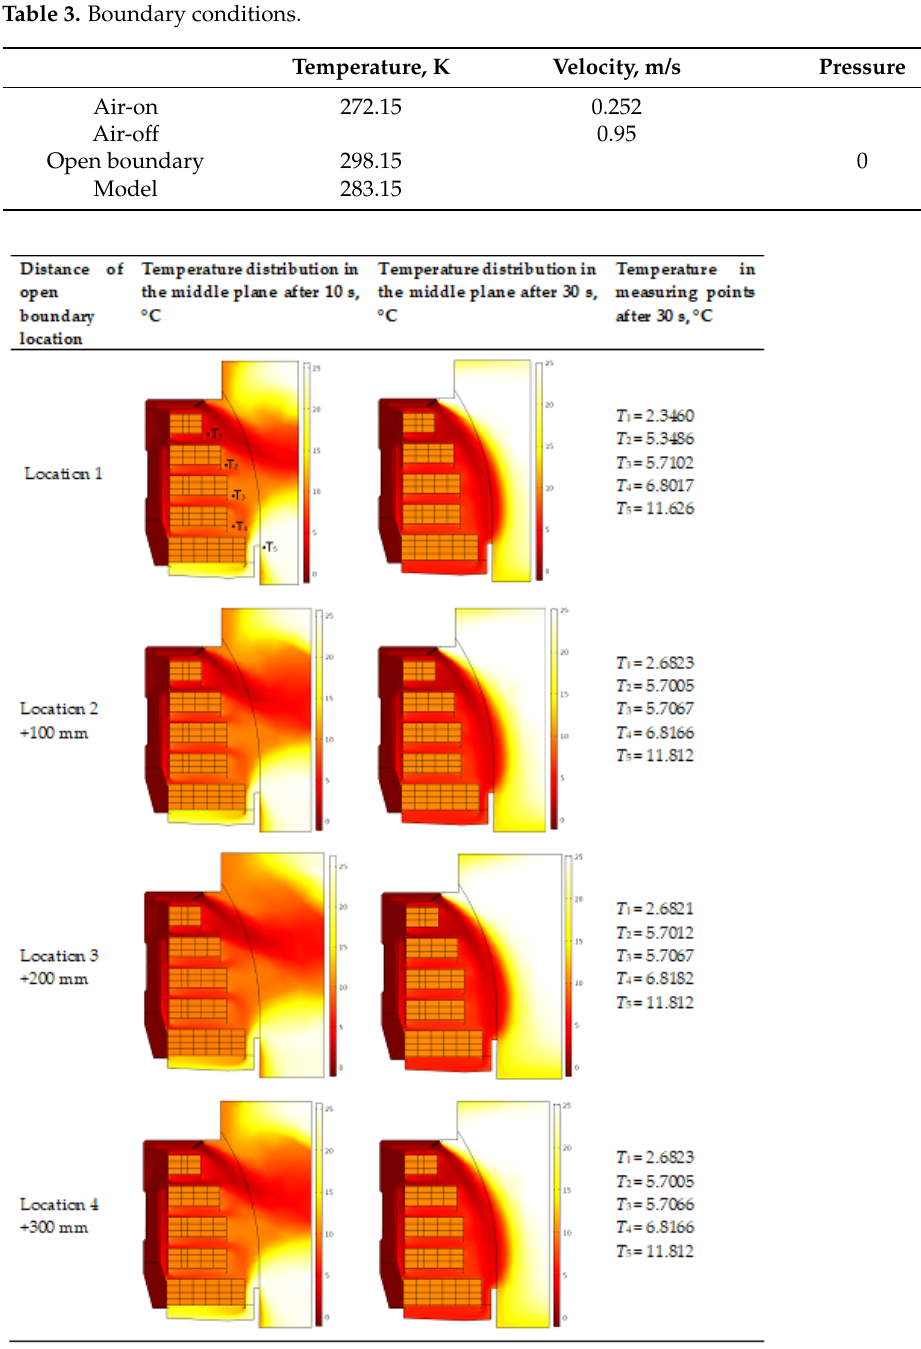
Figure 4. Influence of the location of the open boundary on the air temperature in the middle plane.